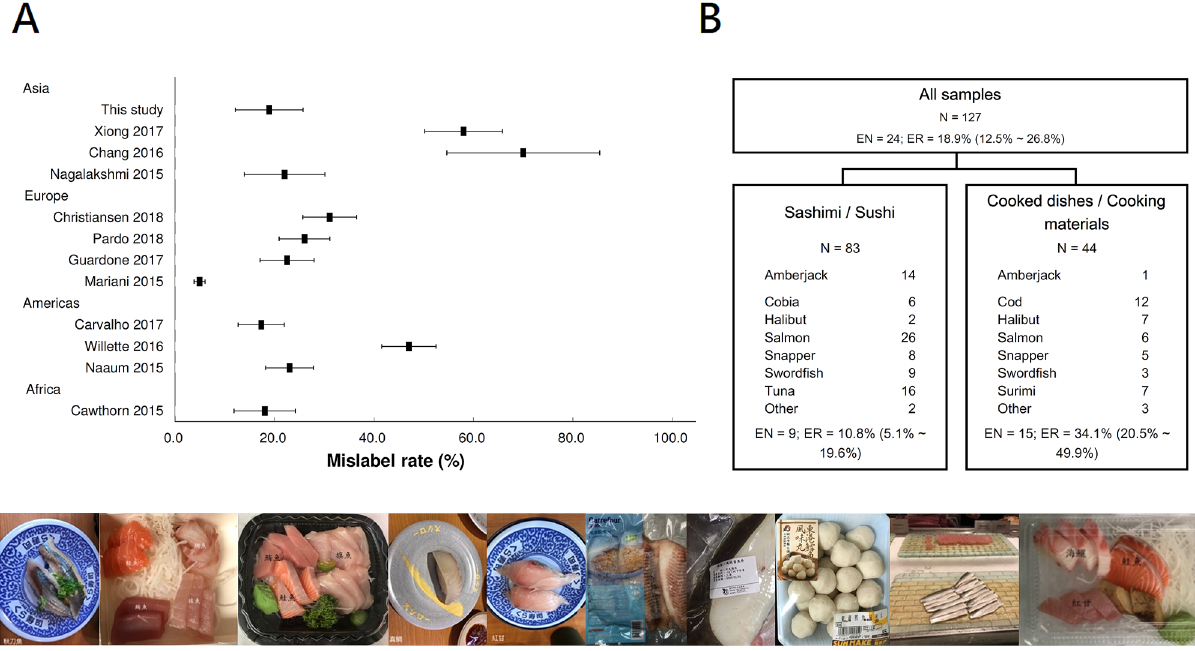
Figure 2. ( A ) The mislabel rate and 95% confidence interval in this study and in literature. ( B ) Seafood product categories and their corresponding mislabel rates in this study. A total of 127 seafood samples were collected. Among them, 83 samples are sashimi or sushi (containing fish meat served raw). 44 samples are either already cooked dishes or cooking materials acquired from markets. The gross mislabel rate is 18.9% (95% Confidence interval [CI] = [12.5–26.8%]). The “Other” categories comprise a Dotted gizzard shad sashimi and a Mackerel sashimi, as well as one Saury, one Mackerel, and one Tilapia labeled as “Taiwan Snapper” clearly distinguishable from conventional snapper. N: sample size. EN: Error number. ER: Error